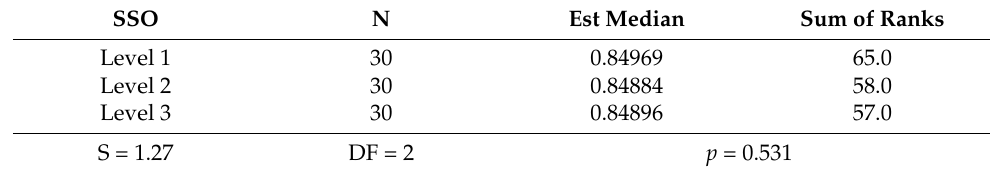
Table 15. Friedman’s test, winter—SSO blocked by DE.